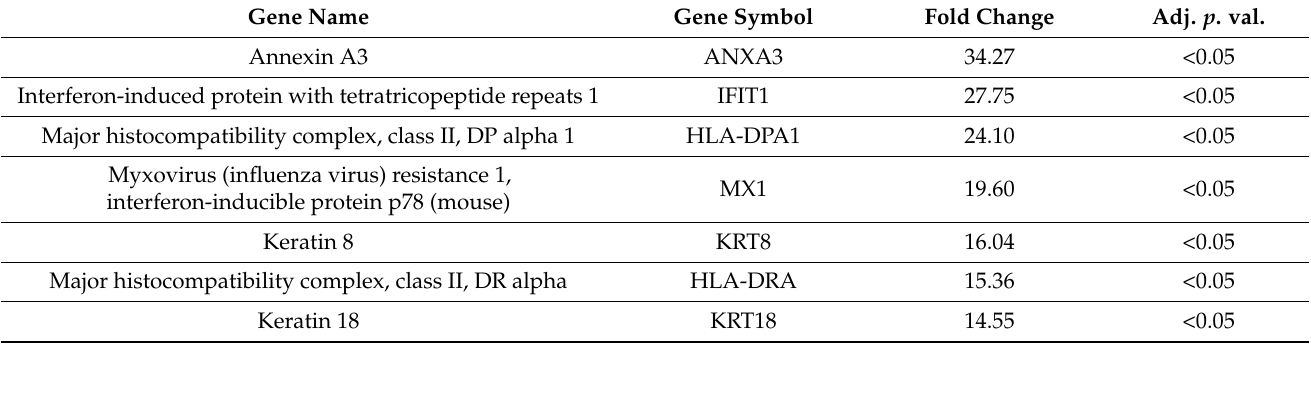
Table 2. The seven most upregulated genes involved in cytokine action and metabolism-mediated signaling pathways activity during immunological defense processes in human cumulus-oophorus cells (CCs). Fold change refers to the Day